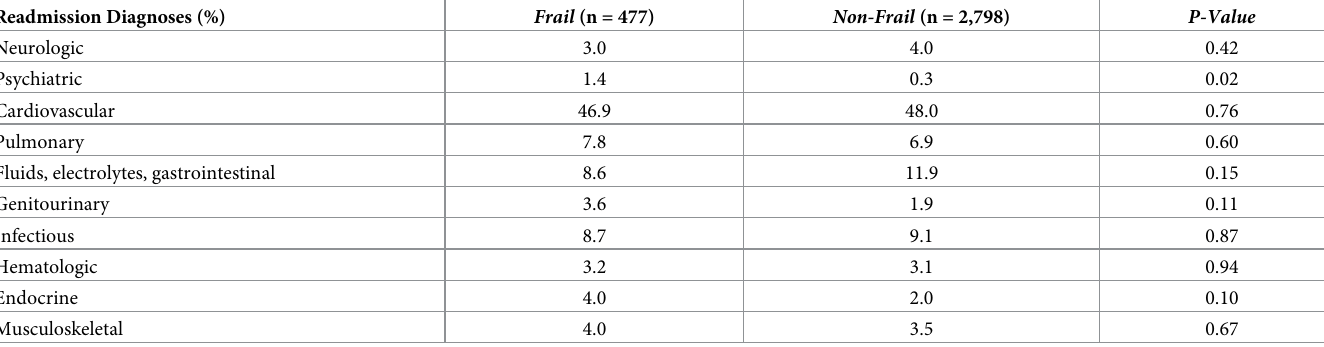
Table 3. Primary readmission diagnoses for patients readmitted following TMVR from 2016–2018 by frail and non-frail cohorts. Readmission Diagnoses (%) Frail (n = 477)